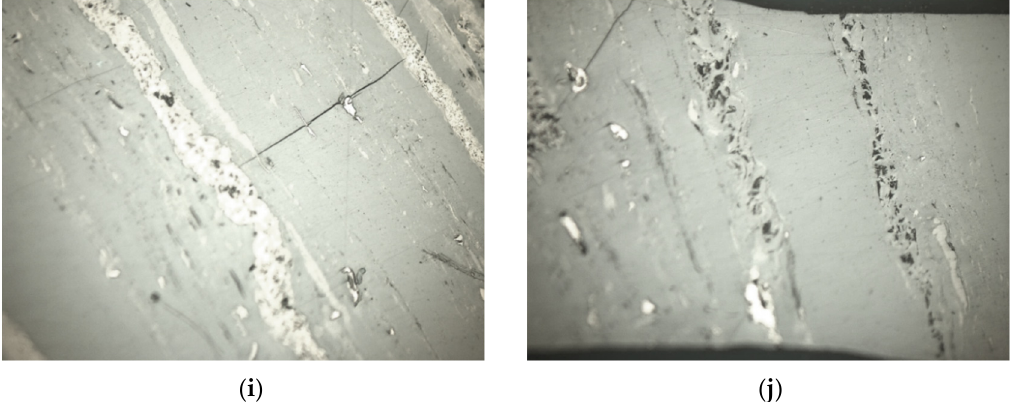
Figure 3. ( a ) D-25—sporinite (macro and microscopic) surrounded by vitrinite and inertinite; ( b ) D-24—lamina of cracked vitrinite surrounded by trimacerite; ( c ) D-34—macro- and microsporinite among macerals of vitrinite and inertinite group; ( d ) D-37—telinite impregnated with micrinite; ( e ) D-6—fragment of coal composed of vitrinite and scattered macerals of inertinite and liptinite group; ( f ) D-22—fragment of lightly cracked coal composed of vitrinite and large macrospore and inertinite fragments; ( g ) D-7—vitrinite with bands of mineral matter, mainly clay; ( h ) D-23—fragment of coal composed of colotelinite, sporinite and small fragments of inertodetrinite; ( i ) Cz. 4032—vitrinite with macerals of inertinite group; ( j ) Cz. 4006—vitrinite with macerals of the inertinite group. Magnification 500×, reflected light, immersion.